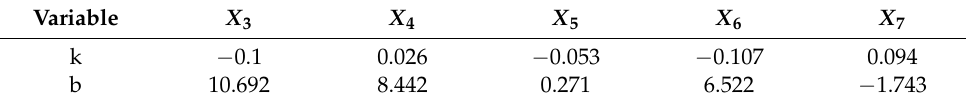
Table 4. Coefficients and constants between environmental regulations and control variables.